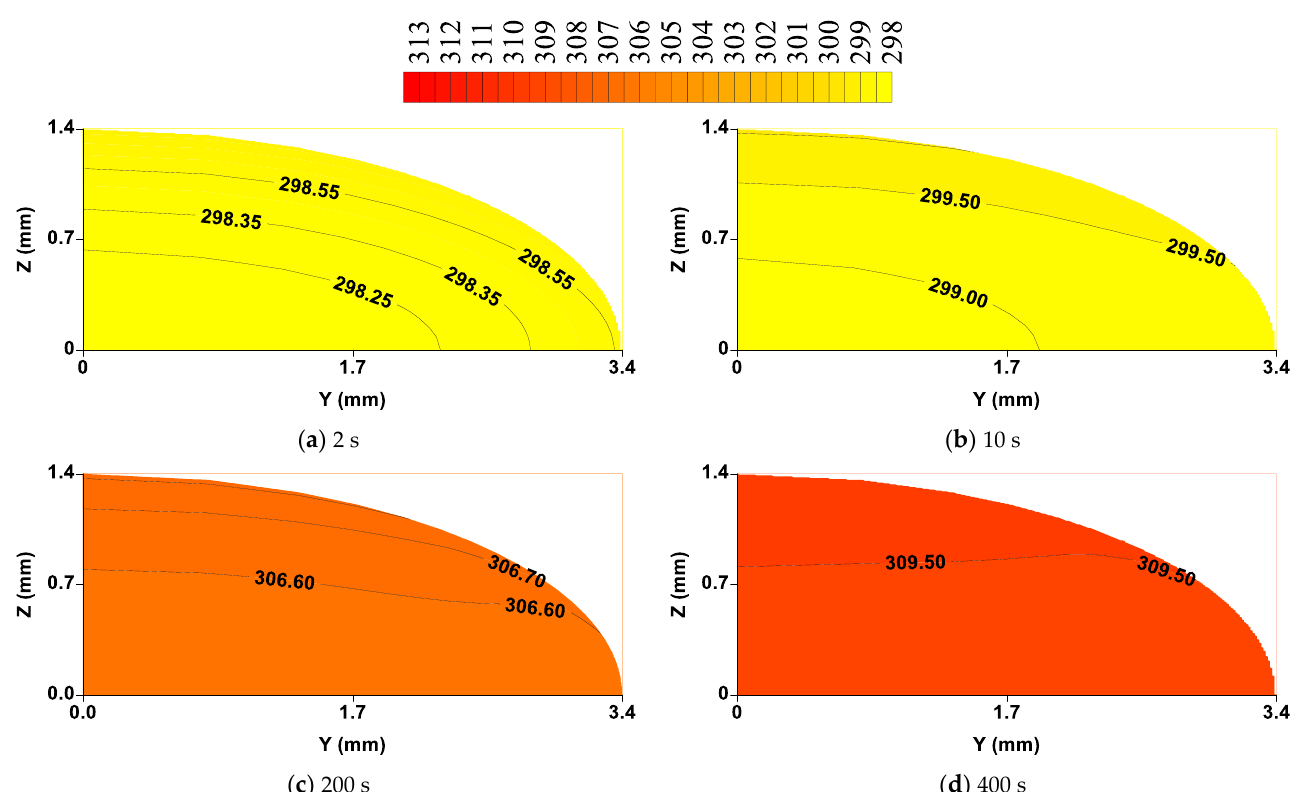
Figure 9. Temperature distribution inside the lentil grain at different process moments, for drying at 40 °C and a relative humidity of 50%. Table 2. Comparison between the liquid and vapor conductivity and residual